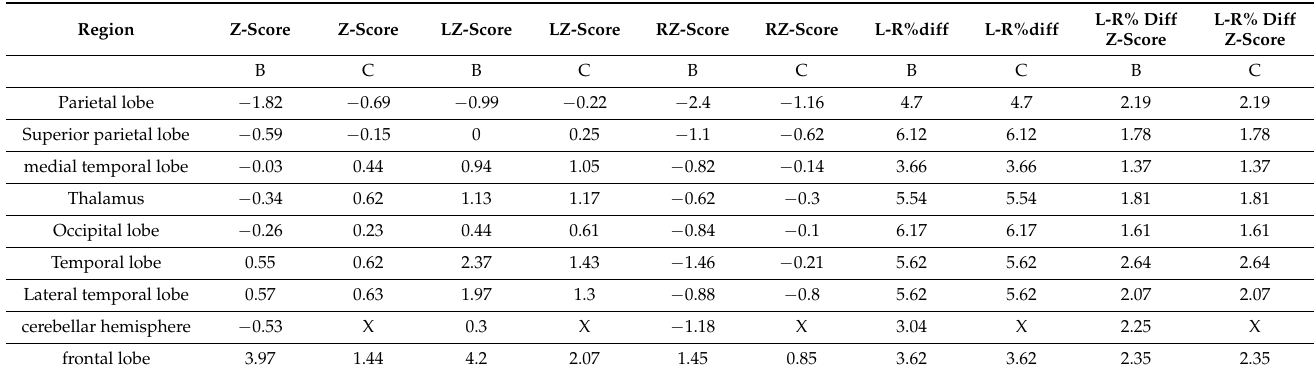
Table 1. Z-score results from SPECT quantitative analysis, B—perfusion normalized to whole brain C- perfusion normalized to cerebellum.